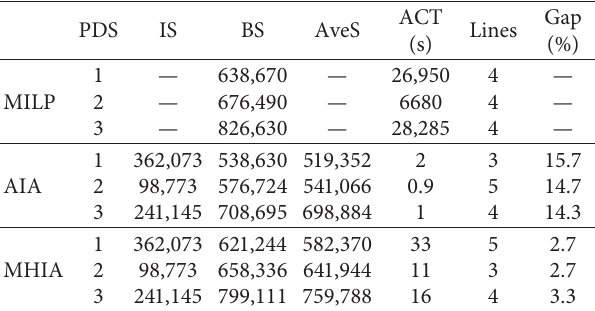
Table 4: Comparison between different approaches on the small example network.